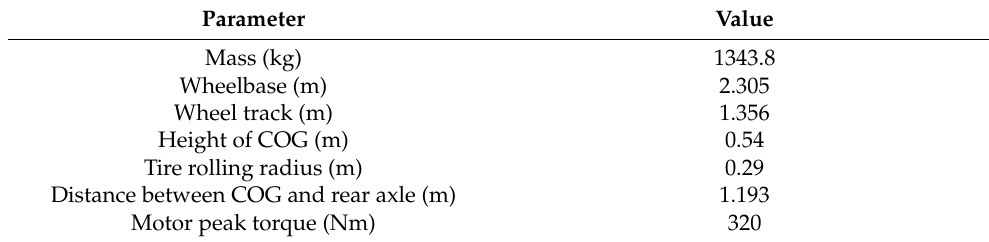
Table 3. Main parameters of the test